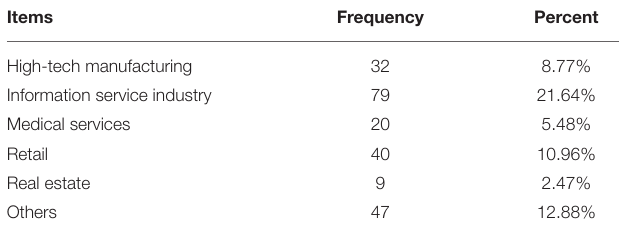
TABLE 2 | Distribution of individual-level data ( n = 365).